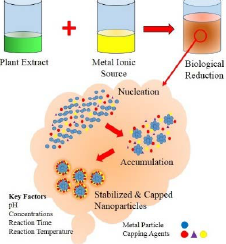
Figure 1. Biological synthesis of nanoparticles using plant extracts.